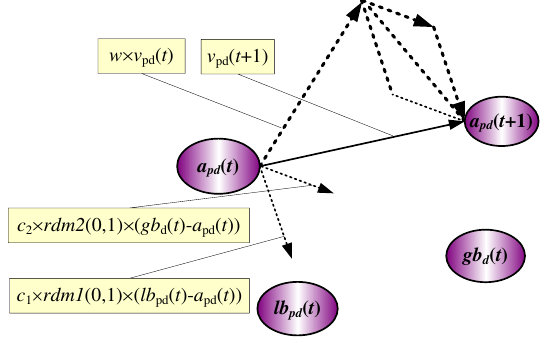
Fig. 5. Relationship between velocity and